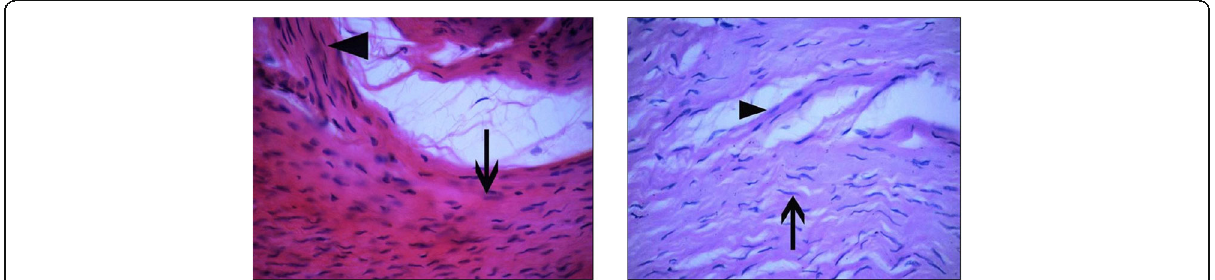
Fig. 1 Predominance of the transverse collagen fibres in the upper and lower borders of the ring of the direct umbilical hernia (the arrow points to the transverse fibres while the arrowhead points to the oblique